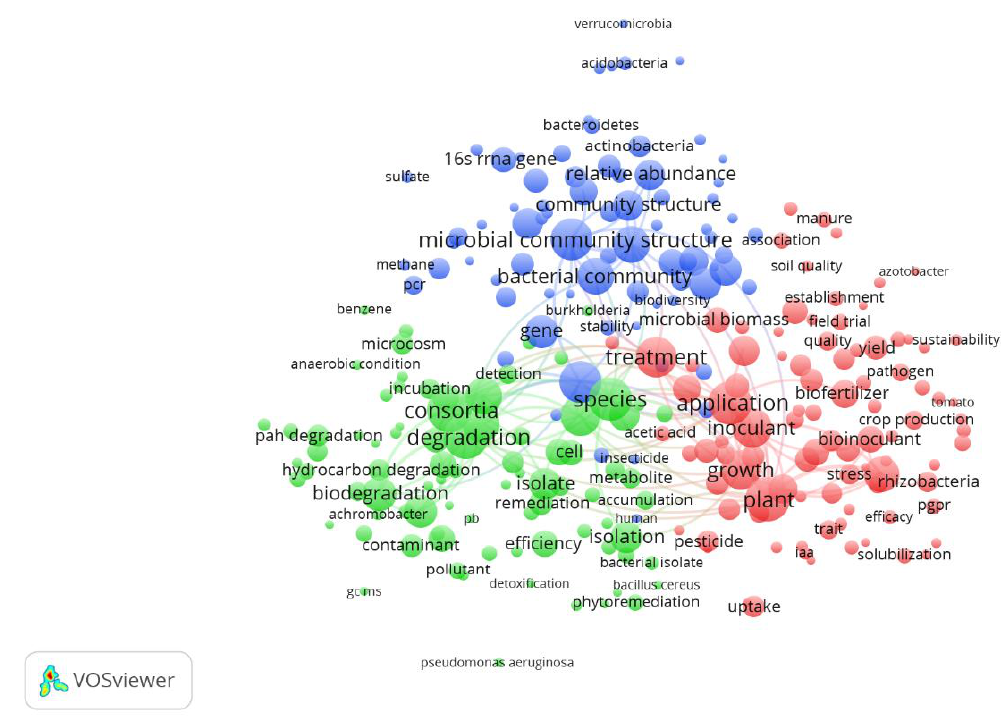
Figure 6. The terms clustering map based on the Scopus soil microbial inoculants publications from 2000 to 2020. Different colors (red, green, blue) represent the terms belonging to different clusters. The size of the term is based on the number of occurrences. The connecting lines indicate the 100 strongest co-occurrence links between terms.